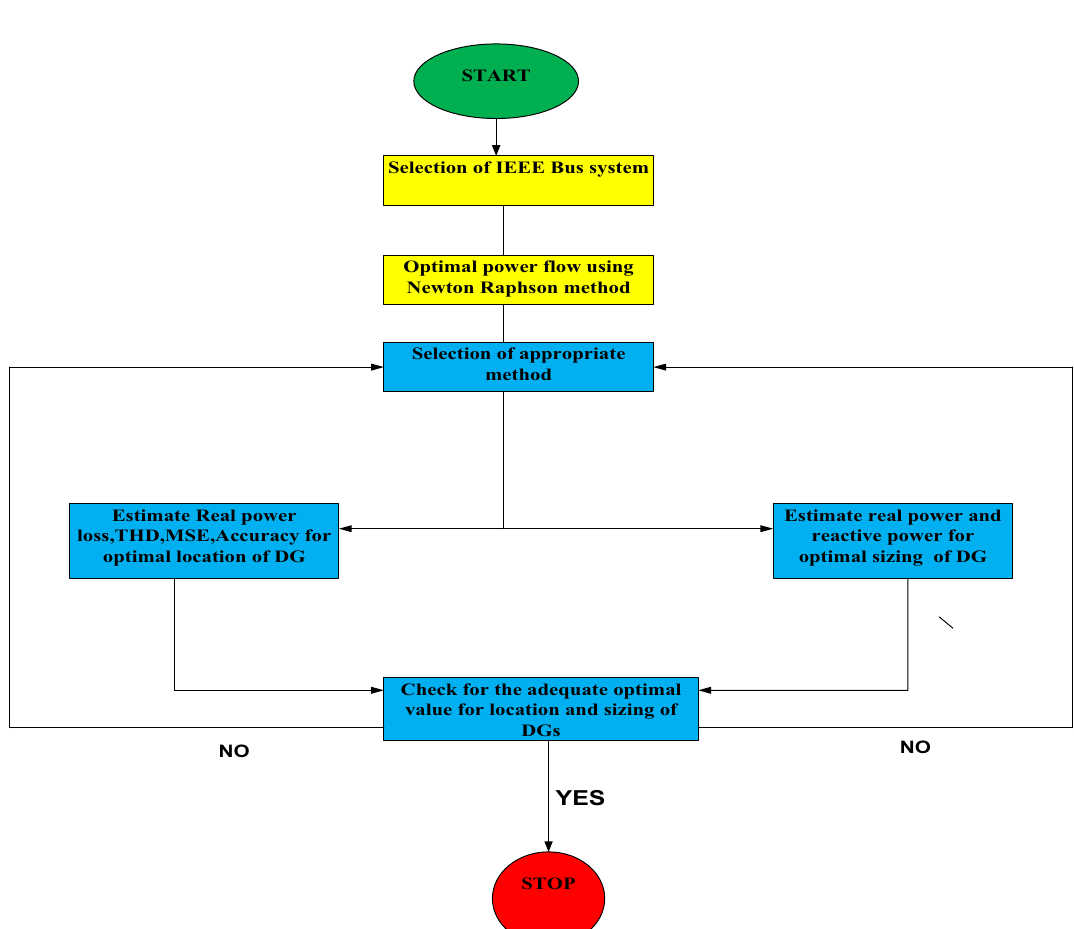
Fig. 5 Flowchart illustrating the process of selection of optimal location and sizing of